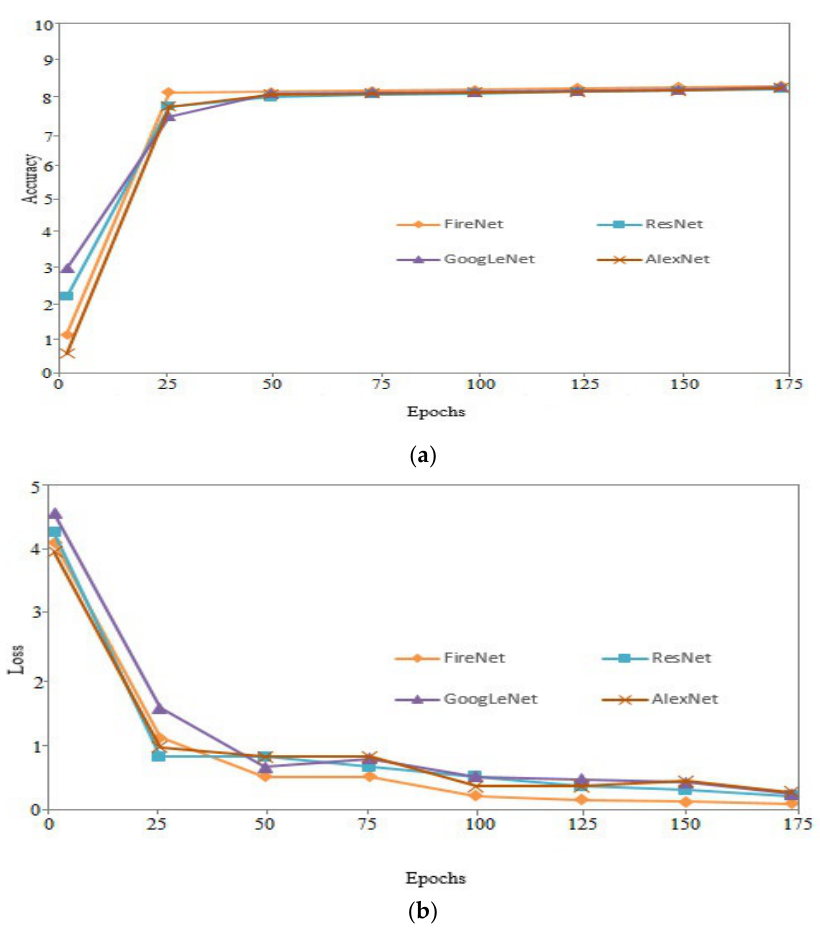
Figure 8. Training progress of our proposed FireNet model with the state-of-the-art deep learning models before using NPSO method. ( a ) the performance of FireNet with the state-of-the-art deep learning models during the training phase. ( b ) the performance of FireNet with the state-of-the art deep learning models during the training loss phase.